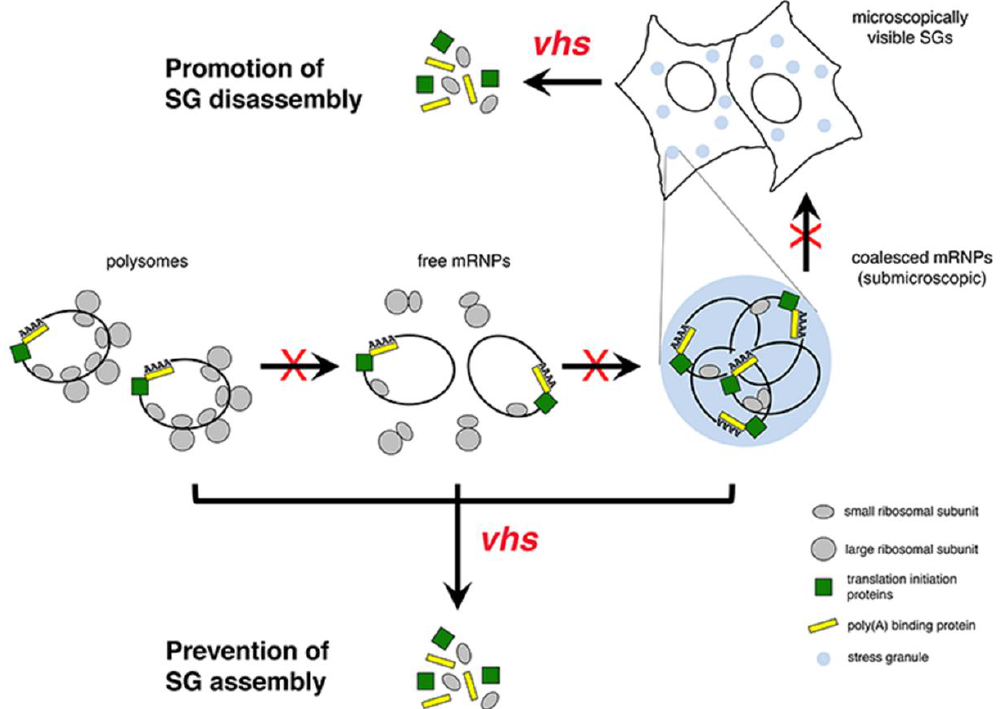
Figure 1. Model of virion host shutoff protein (vhs) endoribonuclease-mediated disruption of stress granule (SG) formation. Two different modes of disruption by vhs are proposed. vhs endoribonuclease activity promotes the destruction of mRNAs present in existing SGs leading to their disassembly. Alternatively or additionally, vhs endoribonuclease activity promotes the destruction of mRNAs present in polysomes, free messenger ribonucleoproteins (mRNPs) or submicroscopic coalesced mRNPs preventing the ensuing step in the SG assembly pathway. For simplicity, microscopically visible SGs as well as submicroscopic coalesced mRNPs that serve as SG nucleation sites are both represented as blue circles; microscopically visible SGs are often irregular in shape and are variable in size.